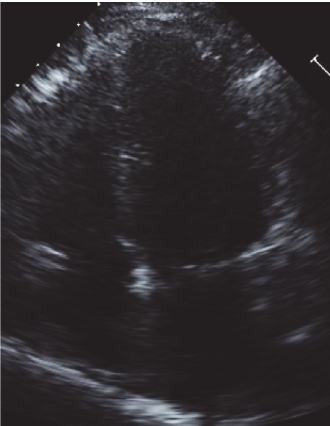
Figure 1: Preoperative TTE, end diastole (preop pics).